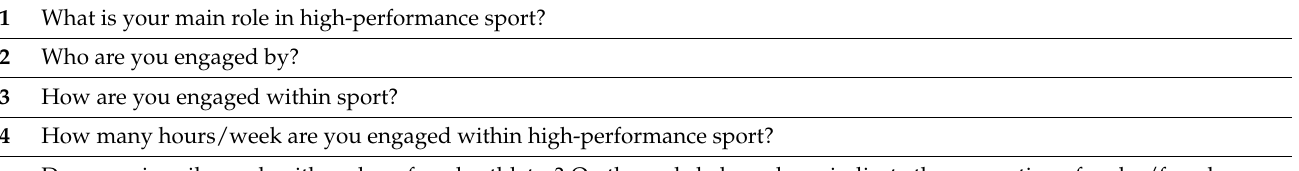
Table A1. Participant demographic questions.